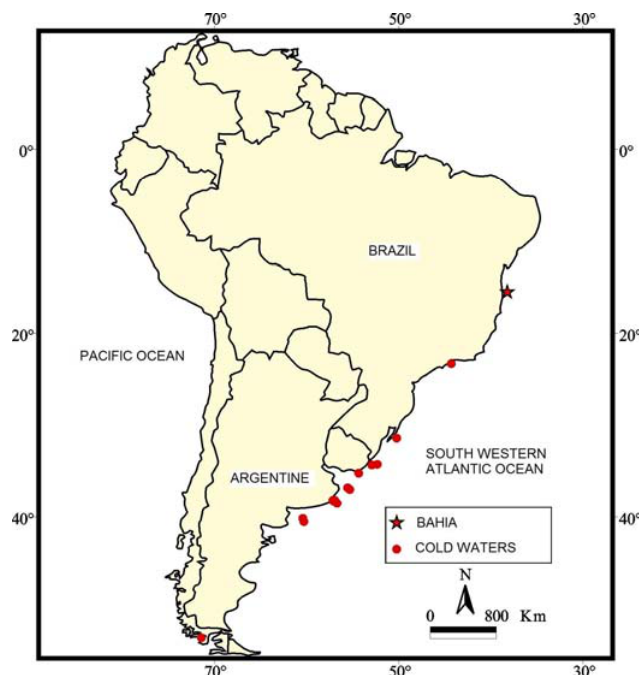
Figure 1 . Distribution map of Tripalea clavaria